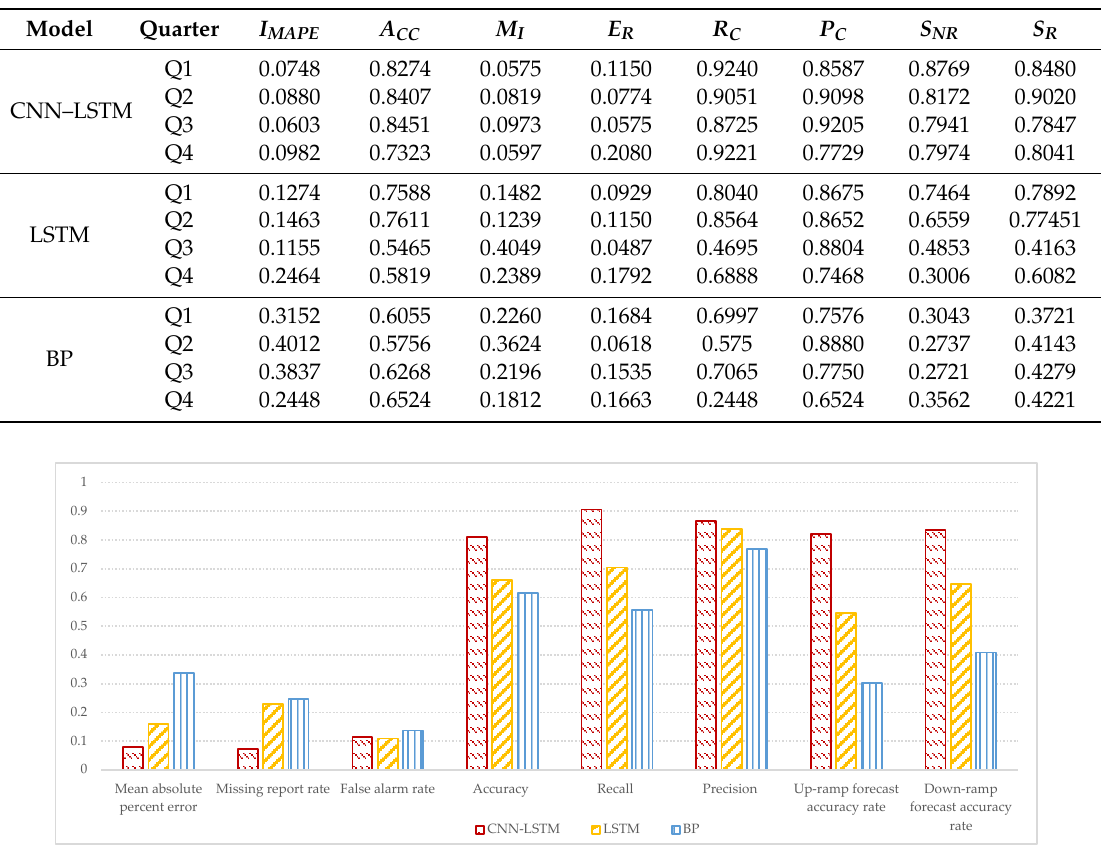
Table 3. Comparison of evaluation indexes with di ff erent forecast models in each quarter. BP: Back Propagation.